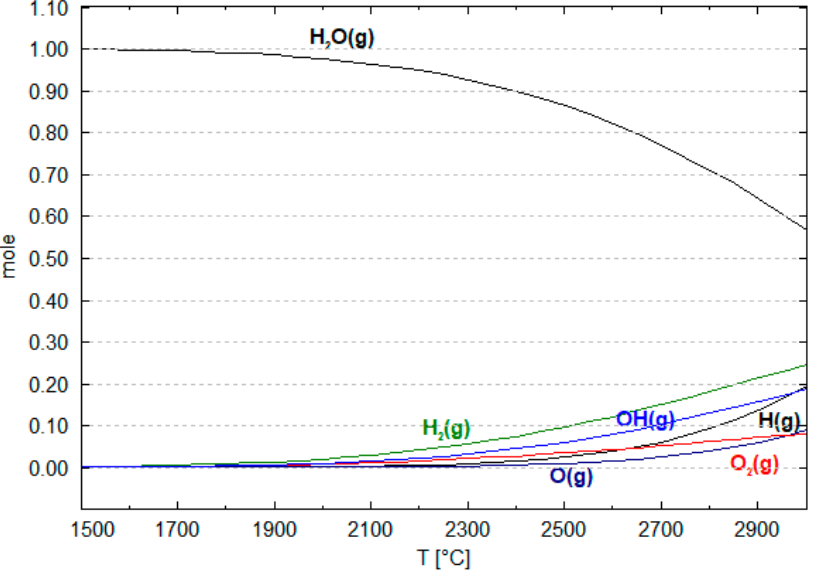
Figure 10. Equilibrium of 1 mol of H 2 O at high temperatures (FactSage™ 7.1, Database FactPS 2017).